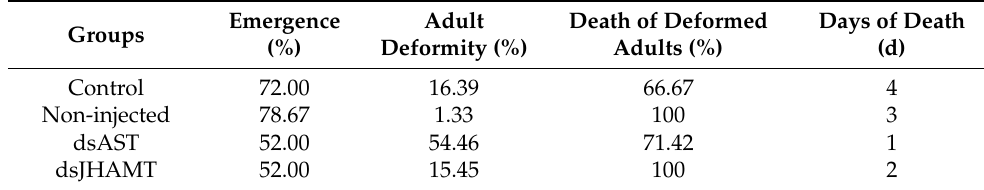
Table 3. Adult development of the dsRNA phenotypes.